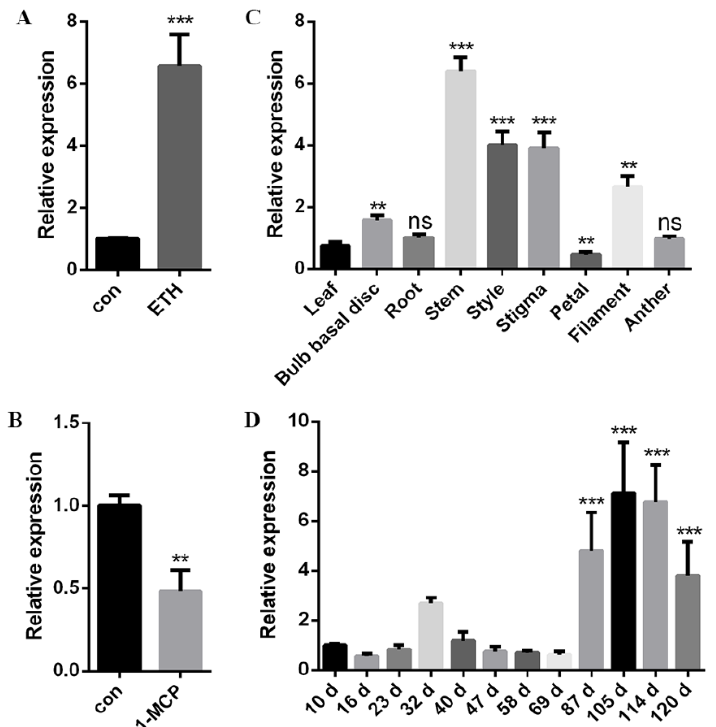
Figure 4. Expression analysis of LlERF110 using qRT-PCR. ( A ) Relative expression of LlERF110 with exogenous 2 ppm ETH treatment. ( B ) Relative expression of LlERF110 with 2 ppm 1-MCP treatment. ( C ) Relative expression of LlERF110 in different tissues of 120-day-old lily. ( D ) Relative expression of LlERF110 at different growth stages, from 10 d to 120 d, in lily. 18S rRNA was used as an internal control. Three independent experiments were performed for each sample with three technical replicates, and the results of one experiment are shown in the figure. T -test analysis of variance was used to identify statistically between different treatment. Samples with different stars are significantly different: ** p < 0.01, *** p < 0.001, ns means